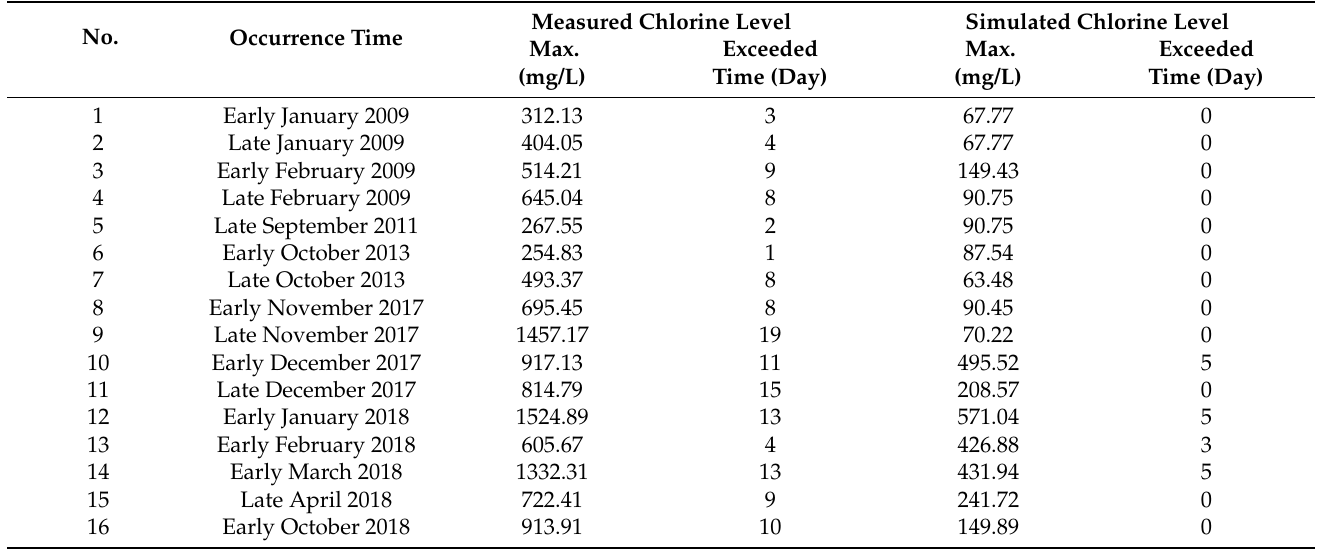
Table 1. Comparison of measured chlorine level and simulated chlorine level after application of seawater suppression